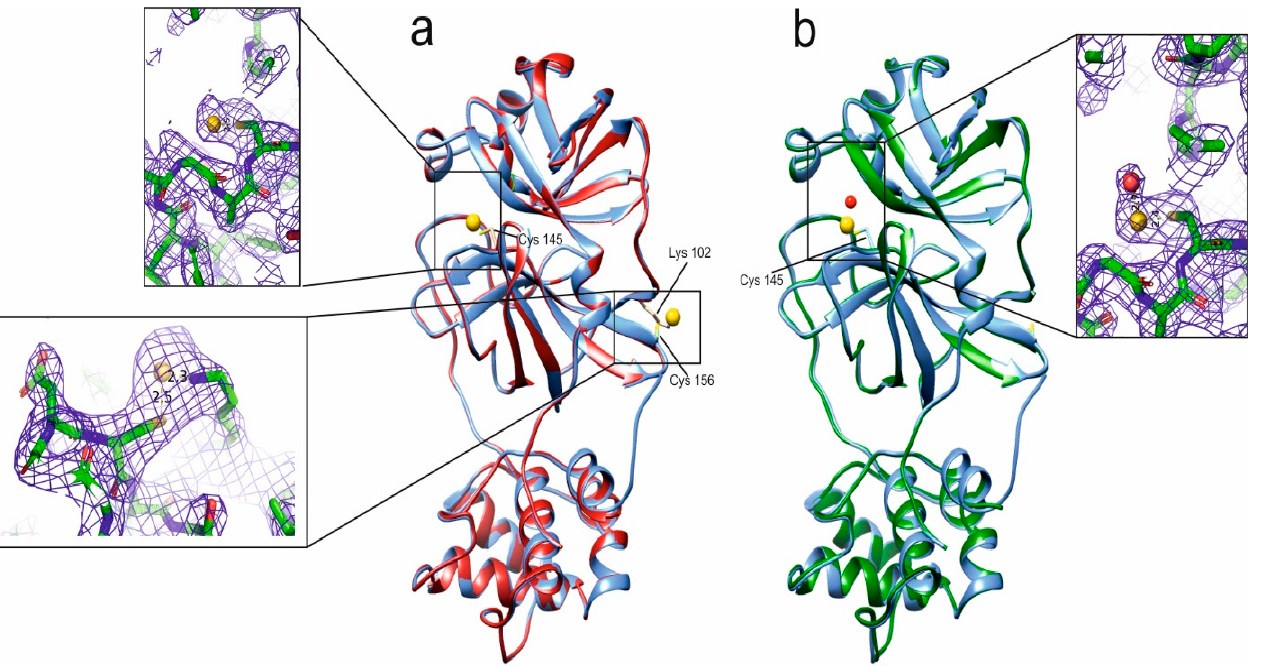
Figure 4. Overlays of ( a ) apo M pro (cyan), (PDBID 7NXH), with M pro -Au(PEt 3 )Br adduct (red) and ( b ) apo M pro (cyan) with M pro - Au(NHC)Cl adduct (dark green). Gold ion is shown as yellow sphere and the water molecule as red sphere. Cys 145, Cys 156 and Lys 102 are shown as sticks. Insets show the 2Fo-Fc electron density contoured at 1 s level of Au(PEt 3 )Br Cys145, Au(PEt 3 )Br Cys156 and Au(NHC)Cl Cys145 coordination environments.